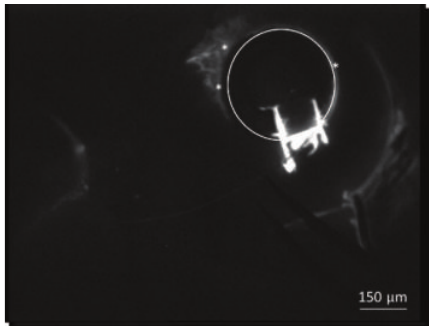
Figure 2: Progression of the dye along Schlemm’s canal starting from the site of injection (arrow). The central shadow is due to the presence of the IR shell protection.